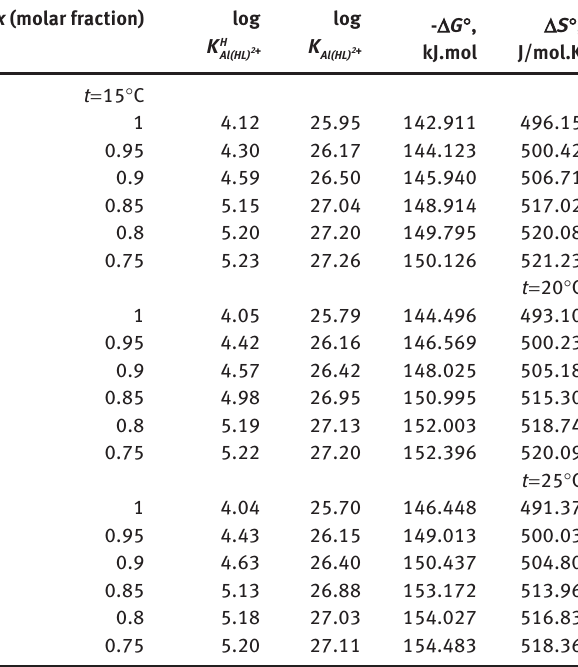
Table 3 Average values of K with adrenaline with standard deviations (0.01) ̧ in ( x ) water + (1 - x ) ethanol at different temperature and I = 0.2 mol.dm -3 .